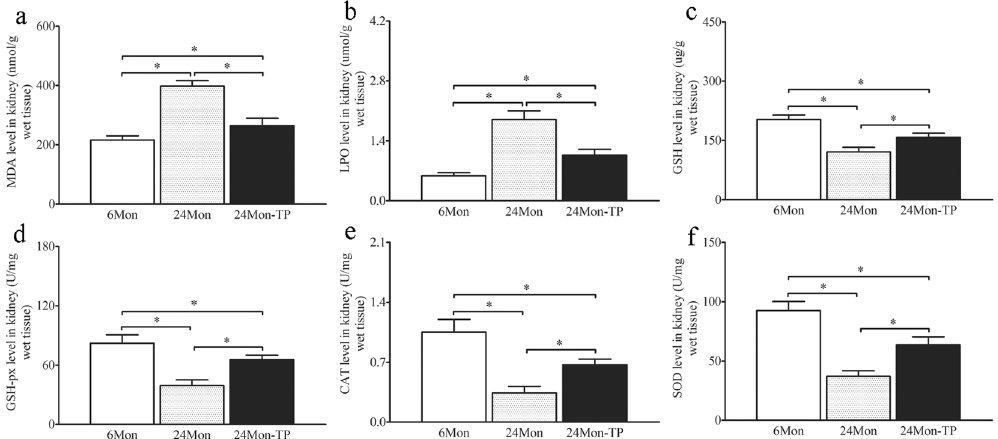
Figure 6. The effects of TP on oxidative stress parameters in the renal tissue of aged rats. MDA ( a ), LPO ( b ), GSH ( c ), GSH-px ( d ), CAT ( e ) and SOD ( f ) levels of the renal tissue were measured. The asterisks show significant differences ( * P <